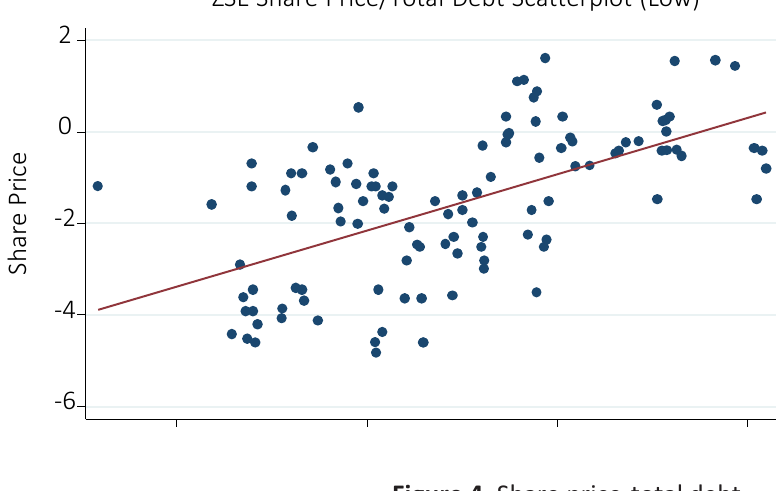
Figure 4. Share price-total debt